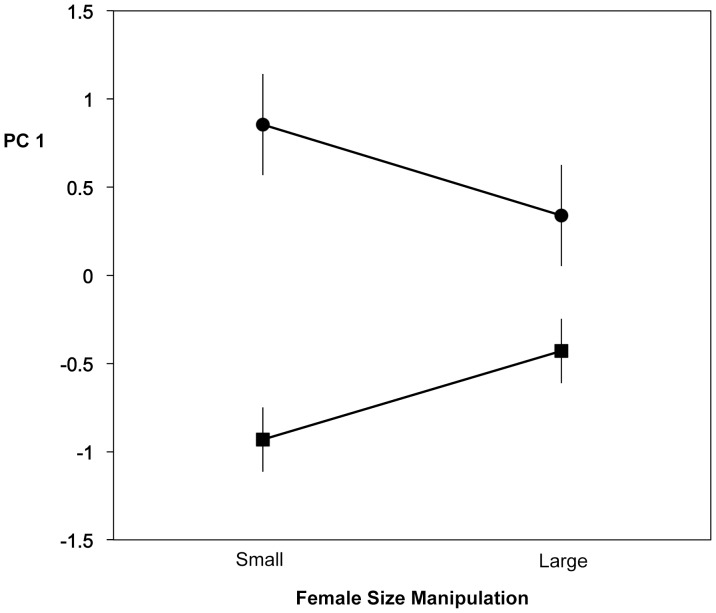
Means for PC1 of log male behaviors versus female size manipulation.Stream male data circles, anadromous male data squares. Error bars are SE’s.